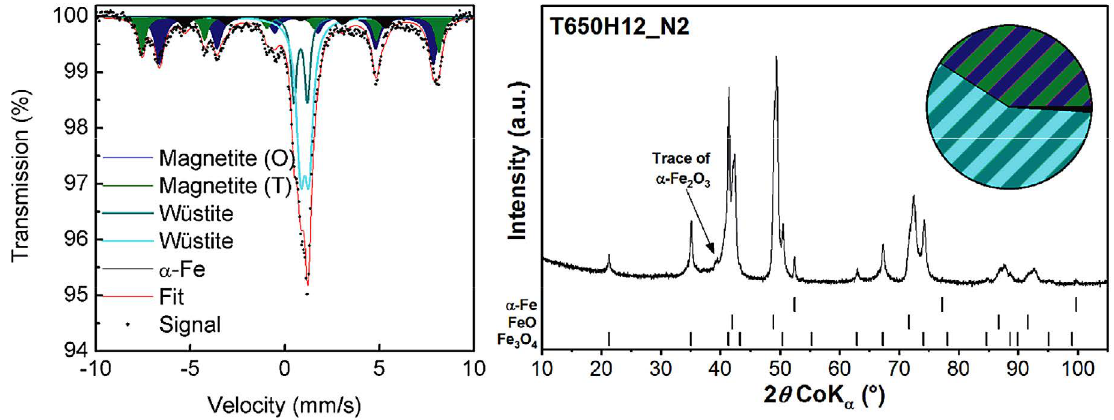
Figure 5 . Mössbauer and XRD data of sample